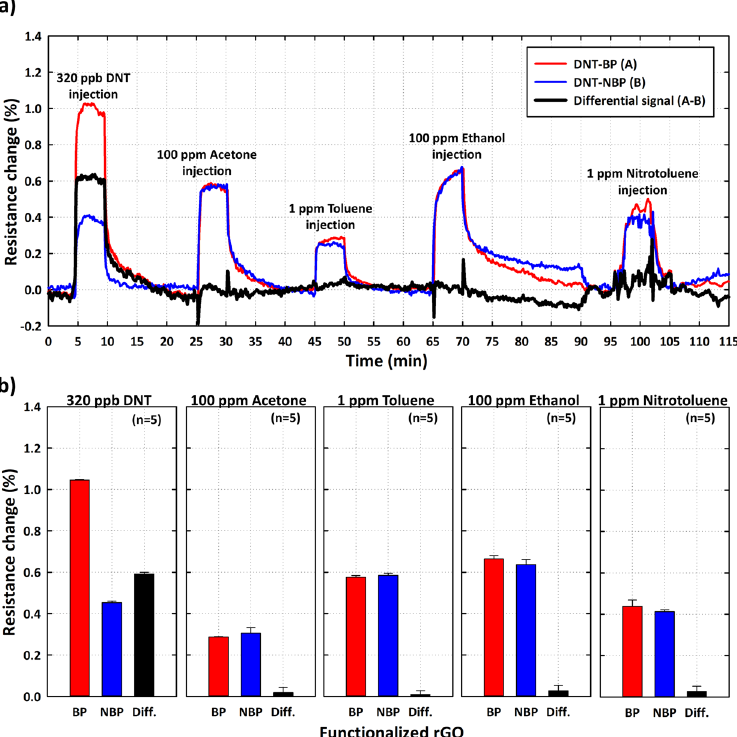
Figure 5. Selectivity test. ( a ) DNT-bp (red), DNT-nbp (blue), and differential signal (black) was monitored in the presence of DNT vapor of 320 ppb, acetone of 100 ppm, toluene of 1 ppm, ethanol of 100 ppm, and nitrotoluene of 1 ppm. ( b ) Average resistance change for each of the five different gases: the differential values (black bar) of DNT-bp and DNT-nbp confirm the high